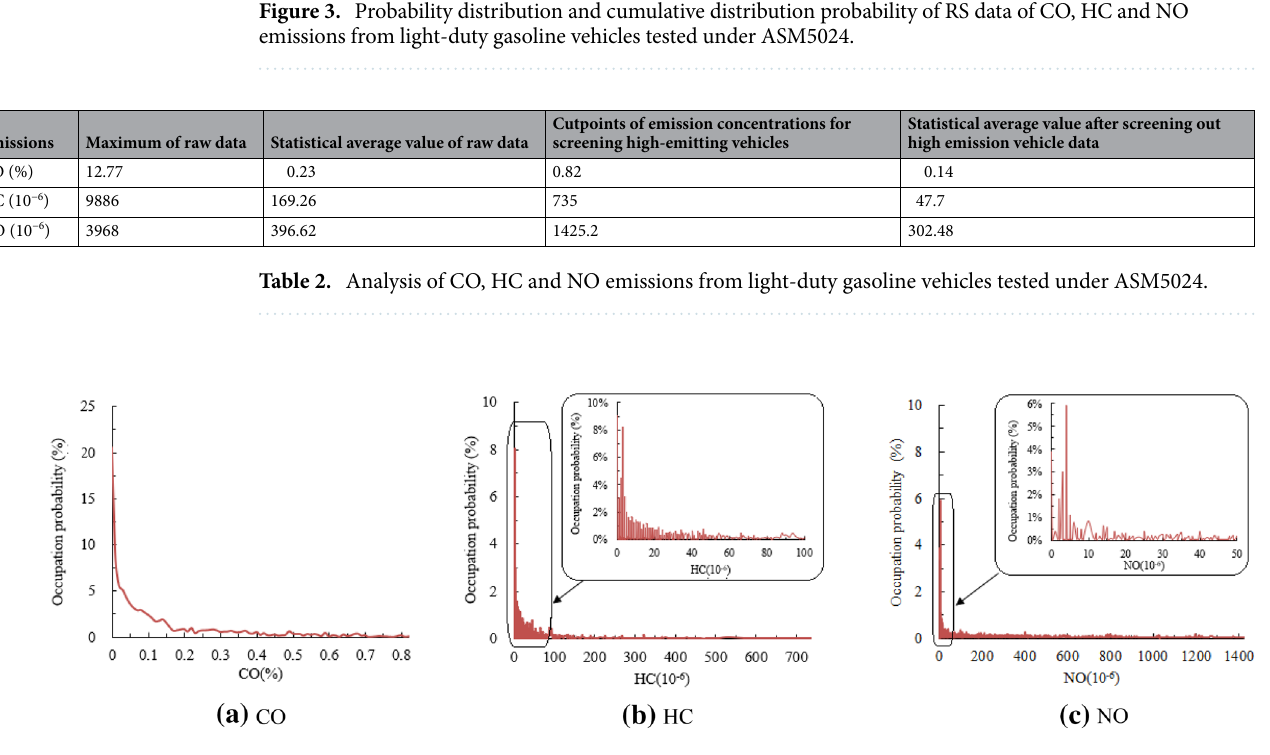
Figure 4. Probability distribution of emission data after excluding 5% high-emitting